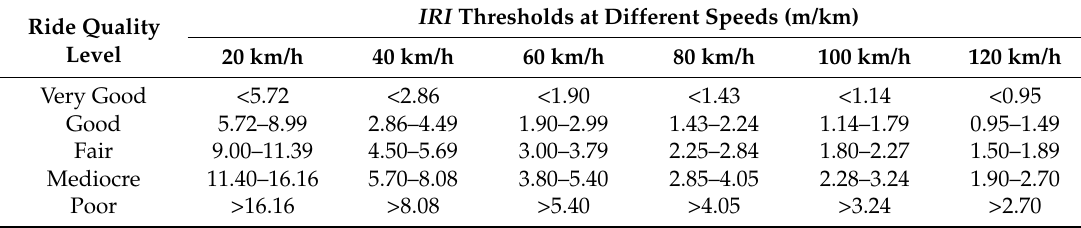
Table 5. IRI thresholds at different speeds suggested by Yu et al. [35].